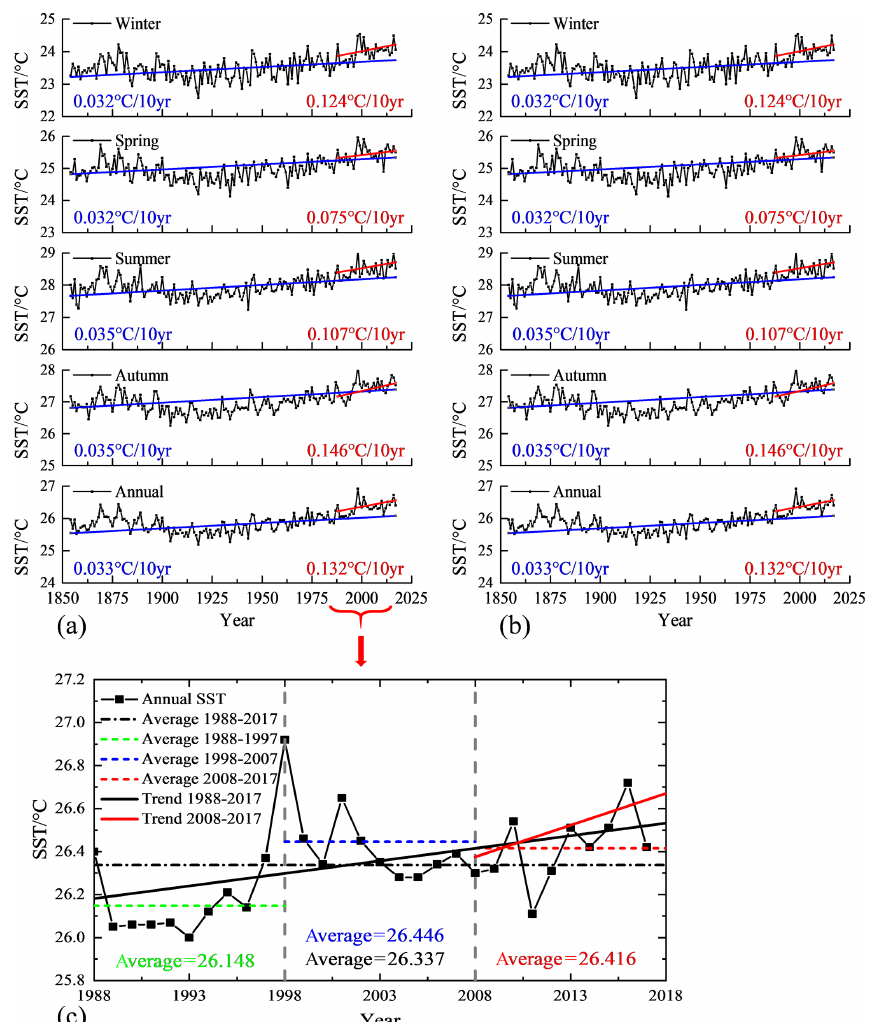
Figure 4. Variability of seasonal/annual SST. (a) The annual SST over the 1854–2017 period; (b) the SST anomaly over the 1854–2017 period; (c) the SST over the 1988–2017 period (the last 30